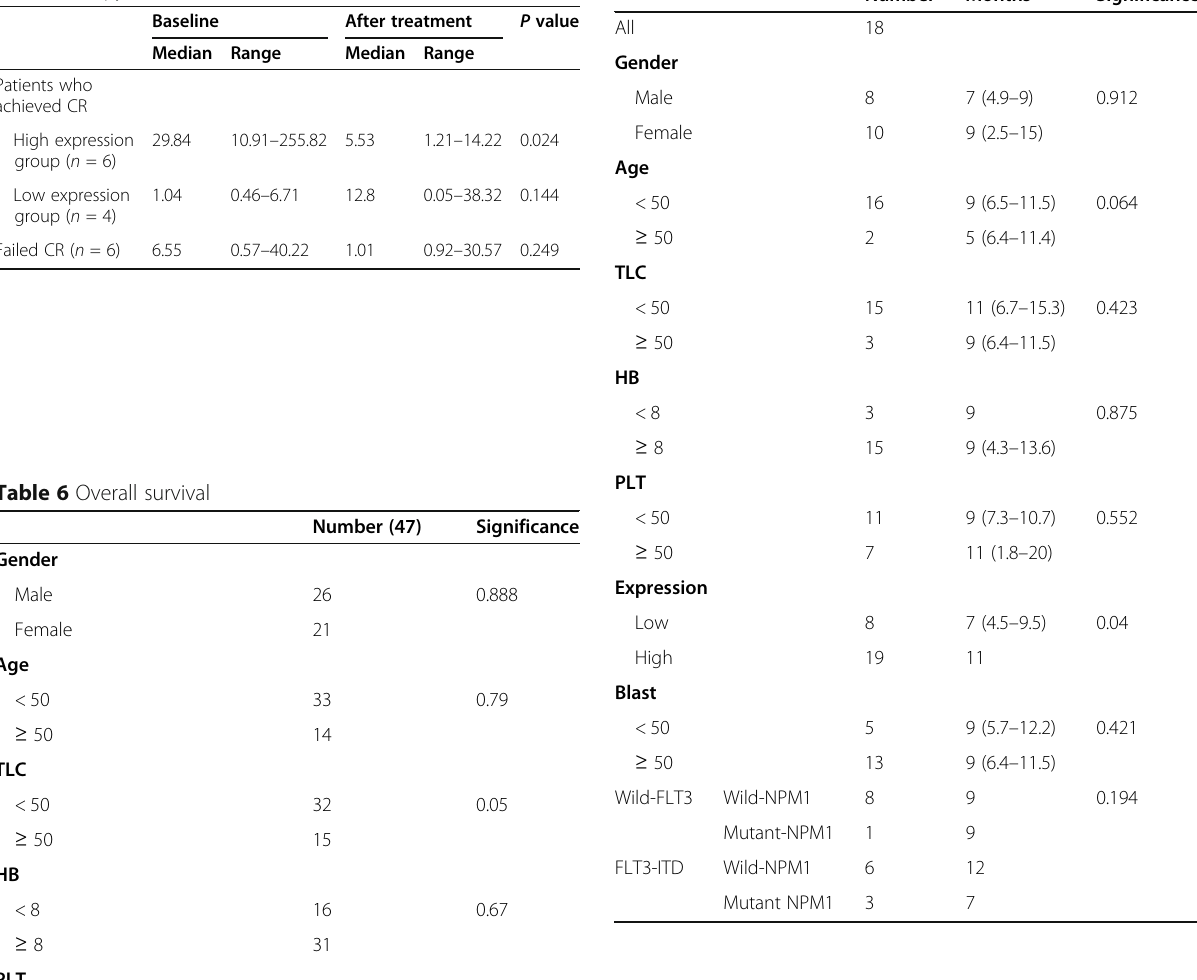
Table 5 HOTAIR expression basal level and after induction